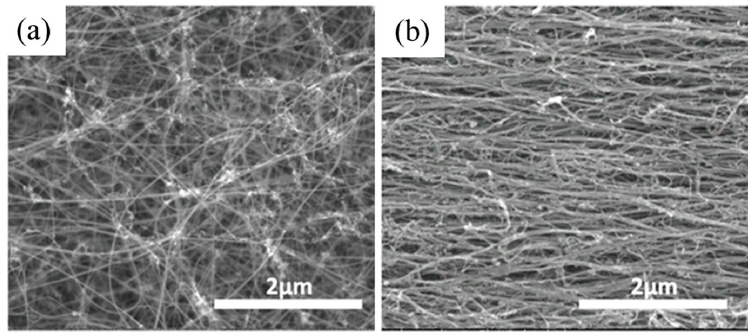
Figure 1. Carbon nanotube sheets before ( a ) and after ( b ) elongation to 30% strain.